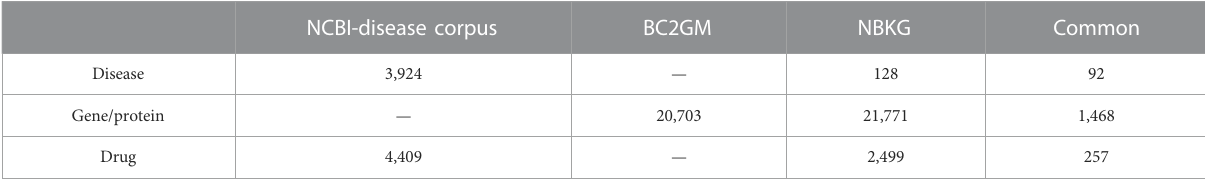
TABLE 1 Quantity of entities in the NBKG and three